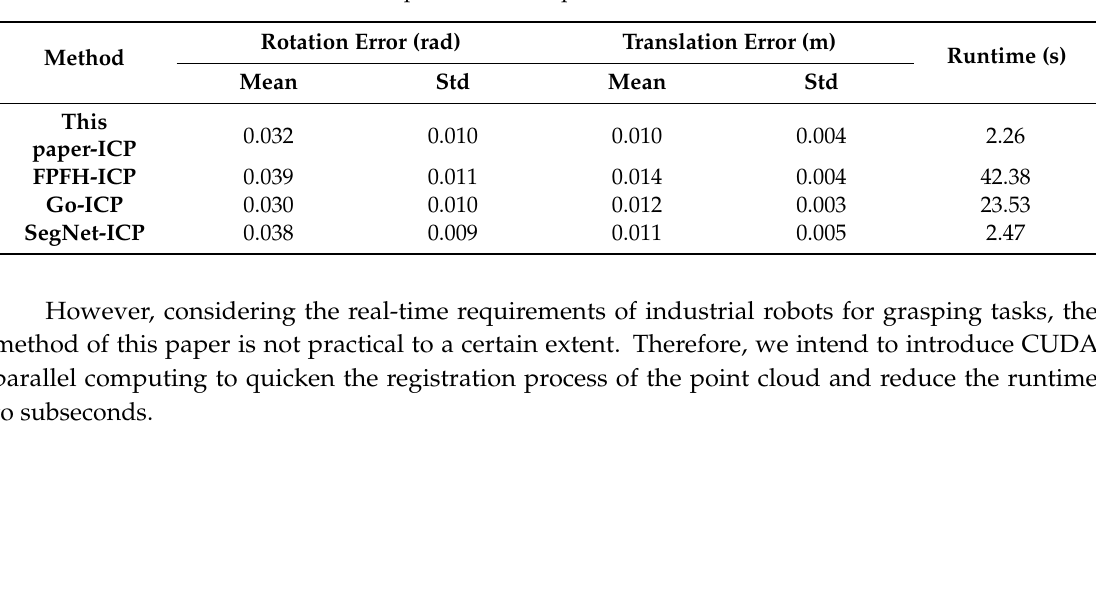
Table 3. The performance of pose estimation